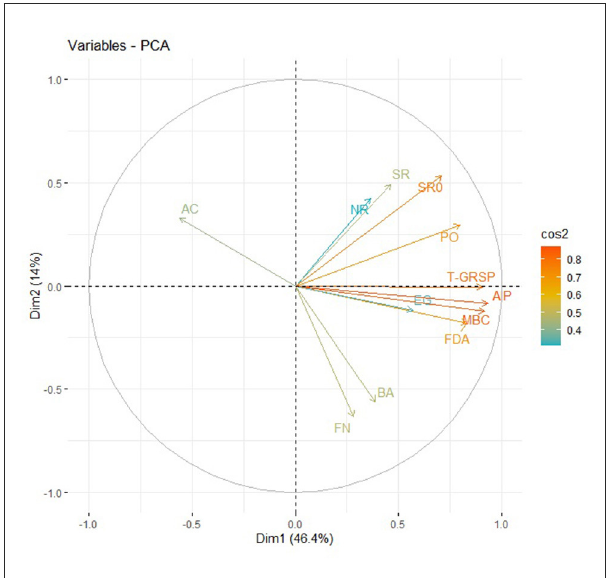
FIGURE3 Graphic display biplot for soil biological attributes as influenced by tillage and residue management practices. BA, Bacteria; AC, Actinobacteria; FN, Fungi; NR, Nitrate reductase activity; SR0, Soil respiration; PO, Peroxidase; SR, Glucose-induced soil respiration; EG, Ergosterol; T-GSRP, Total glomalin-related soil proteins; FDA, Fluorescein diacetate hydrolysis; MBC, Microbial biomass carbon; AP, Alkaline